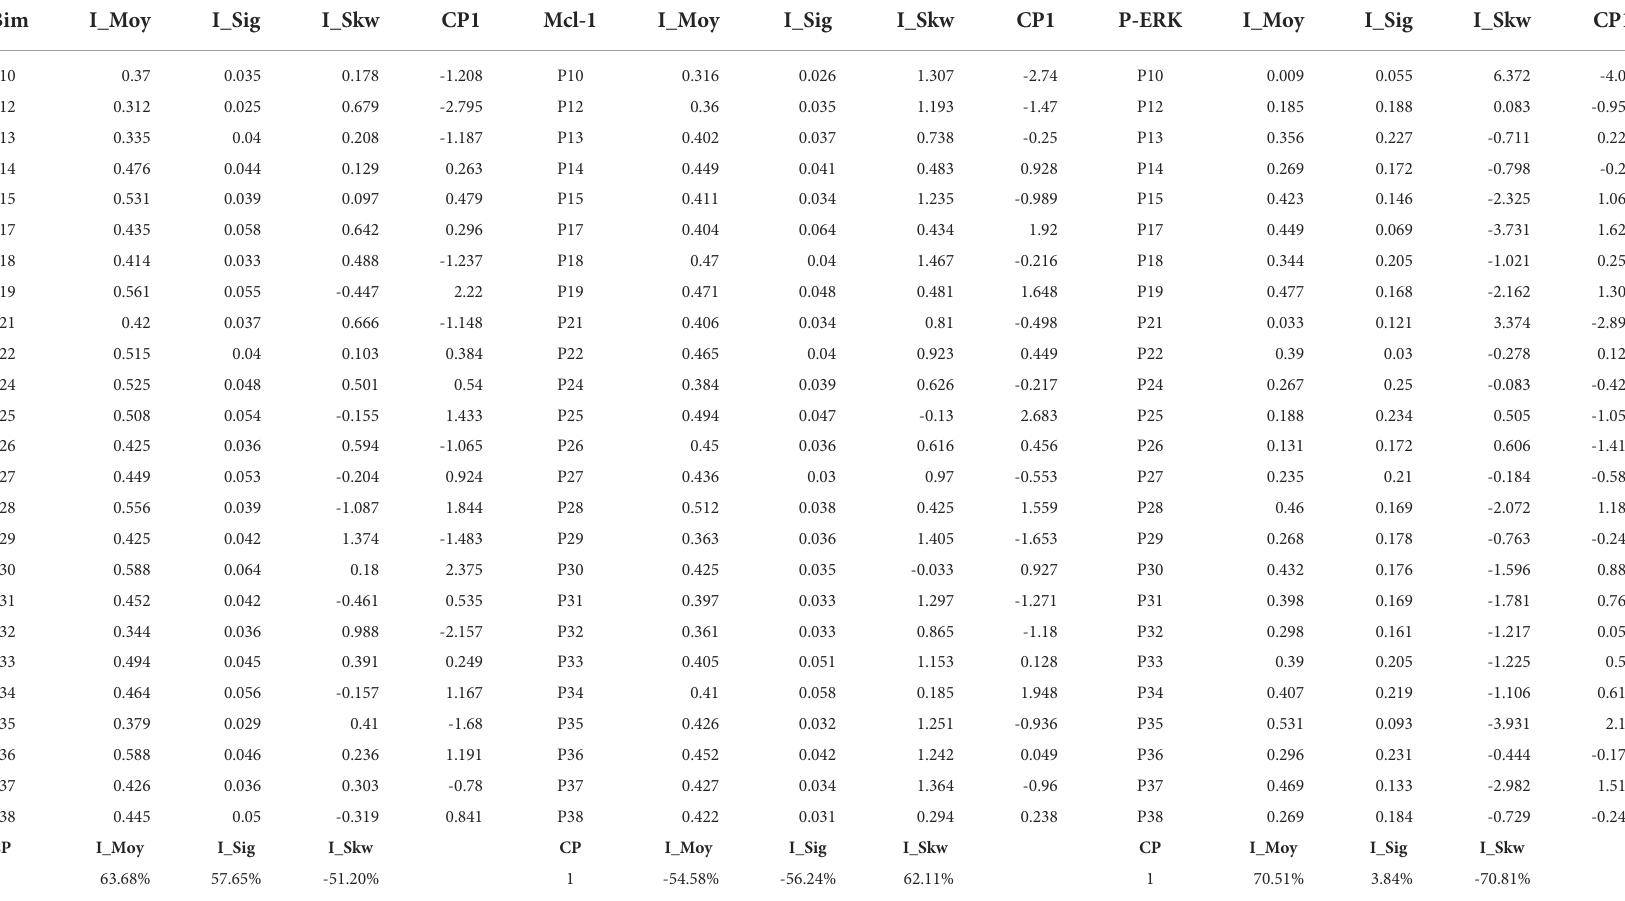
TABLE 5 First three statistical moments in columns on left, values computed by main principal component on right and loadings (weight of statistical moments) for principal component in the last line.